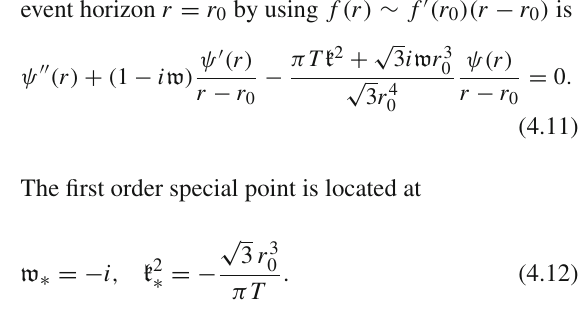
event horizon r = r 0 by using f ( r ) ∼ f (cid:4) ( r 0 )( r − r 0 ) is ψ (cid:4) ( r ψ (cid:4)(cid:4) ( r ) + ( 1 − i w )